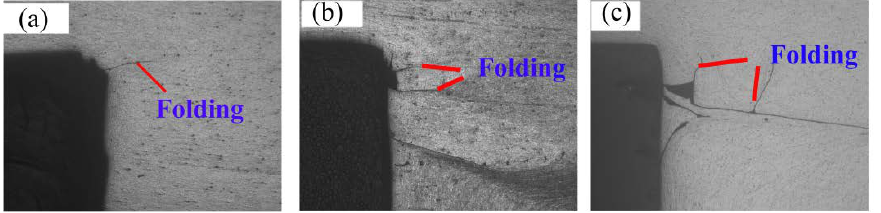
Figure 15. Enlarged graph of root of boss (Magnified 50×) when lengths of bank are: ( a ) l = 55 mm, ( b ) l = 58 mm, and ( c ) l = 60 mm.